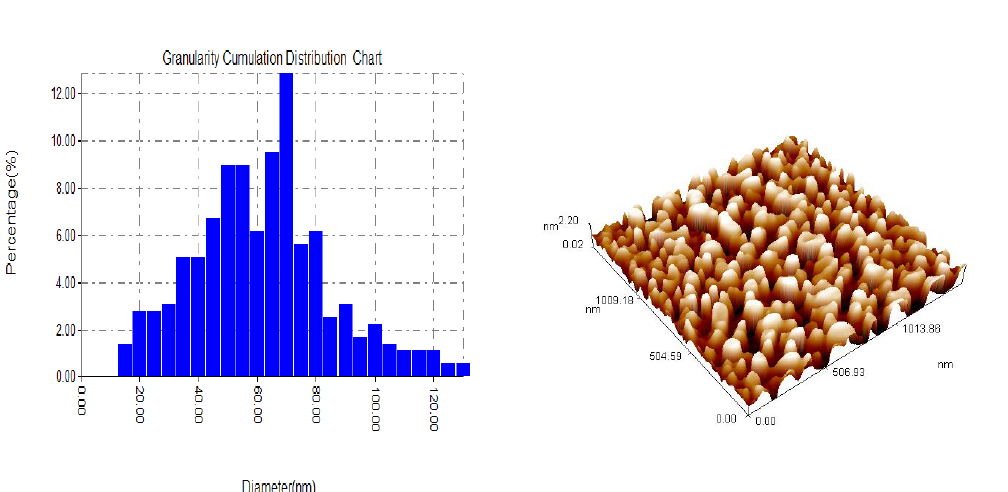
Figure 1: Scanning probe Microscope (Granularity Cumulation Distribution and 3D diagram) of Gr.